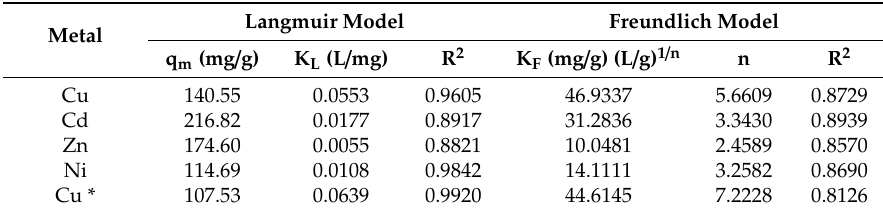
Table 2. Parameters of the Langmuir and Freundlich models. q m = the maximum adsorption capacity for heavy metal ions; K L and K F = equilibrium constants of Langmuir and Freundlich, respectively; n = Freundlich exponent; R 2 = coe ffi cient of determination.